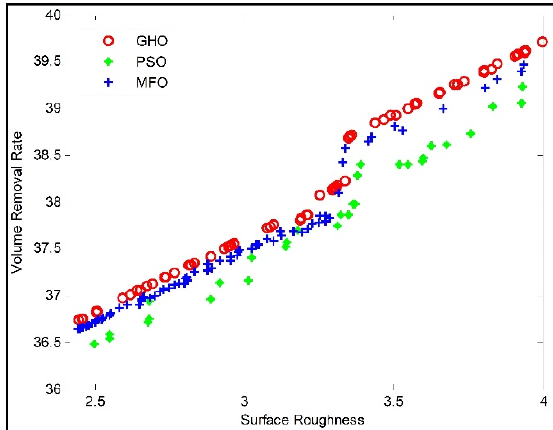
Figure 6. Pareto front diagram for SR vs. VRR.